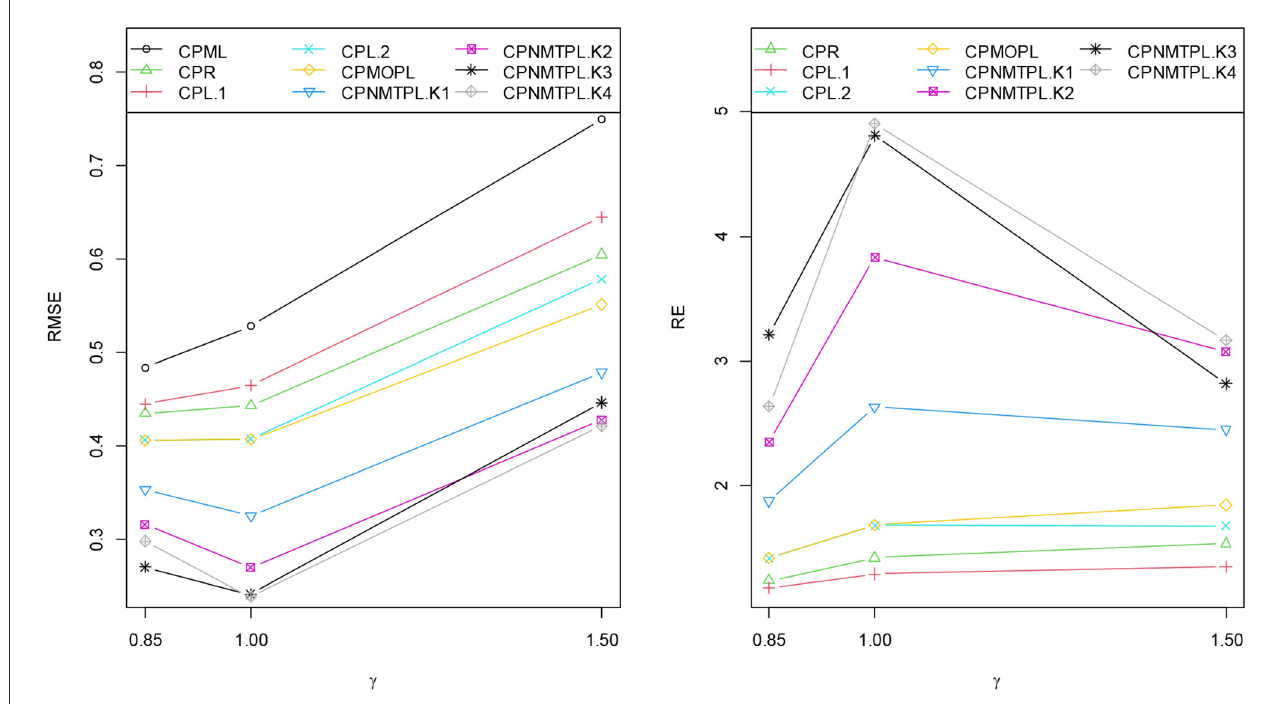
FIGURE4 RMSE and RE categorized by dispersion parameter levels.